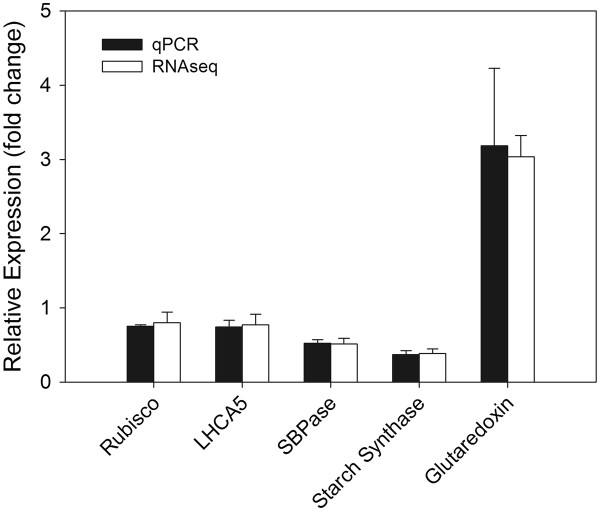
Comparing the accuracy of RNA-Seq data using qRT-PCR. Relative expression ratios determined by qRT-PCR were compared to RNAseq results for several genes known to be regulated by elevated ozone.